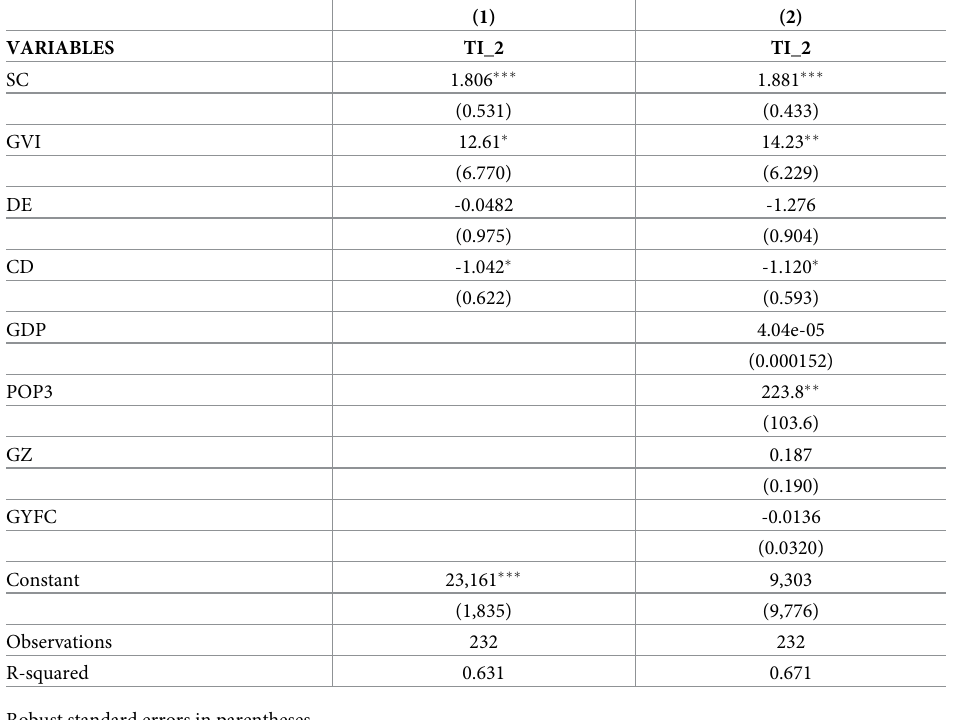
Table 3. Robustness test (replacement of the explained variables).